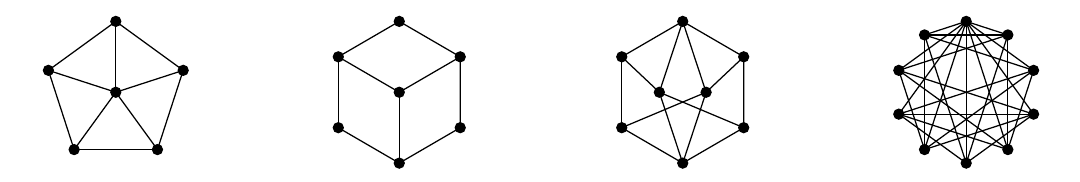
Figure 1: The four graphs on ten vertices or less that have uniform edge betweenness cen- trality but are not edge